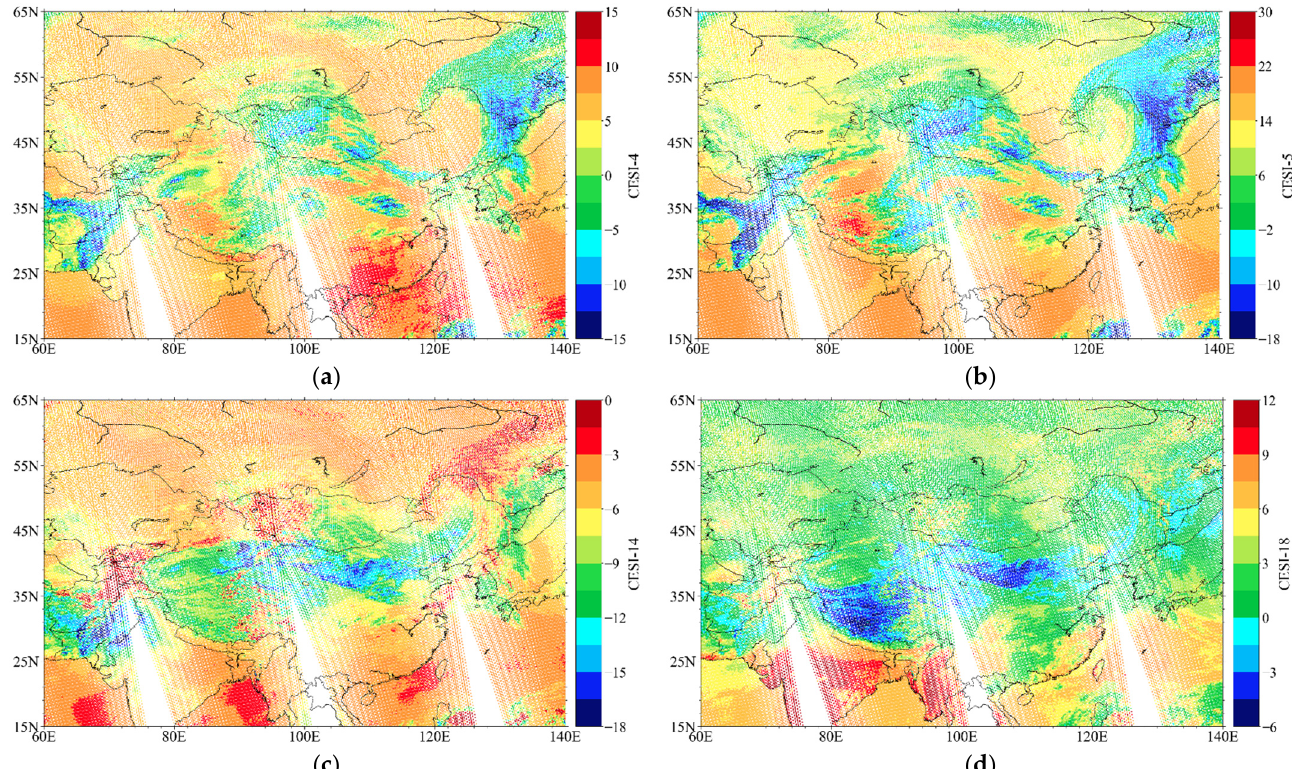
Figure 7. The CESI indices for 15 March 2021. ( a ) CESI-4; ( b ) CESI-5; ( c ) CESI-14; ( d ) CESI-18.